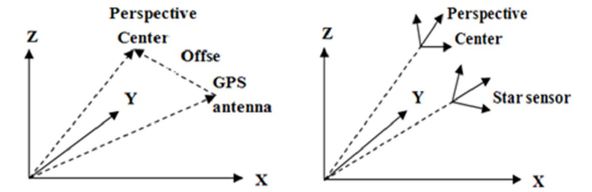
Figure 2: relationship among GPS antenna, Star sensor and Per- spective center